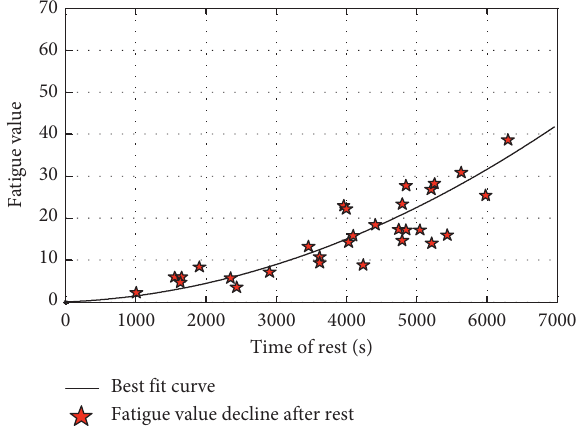
Figure 9: Fatigue value changes caused by rest.